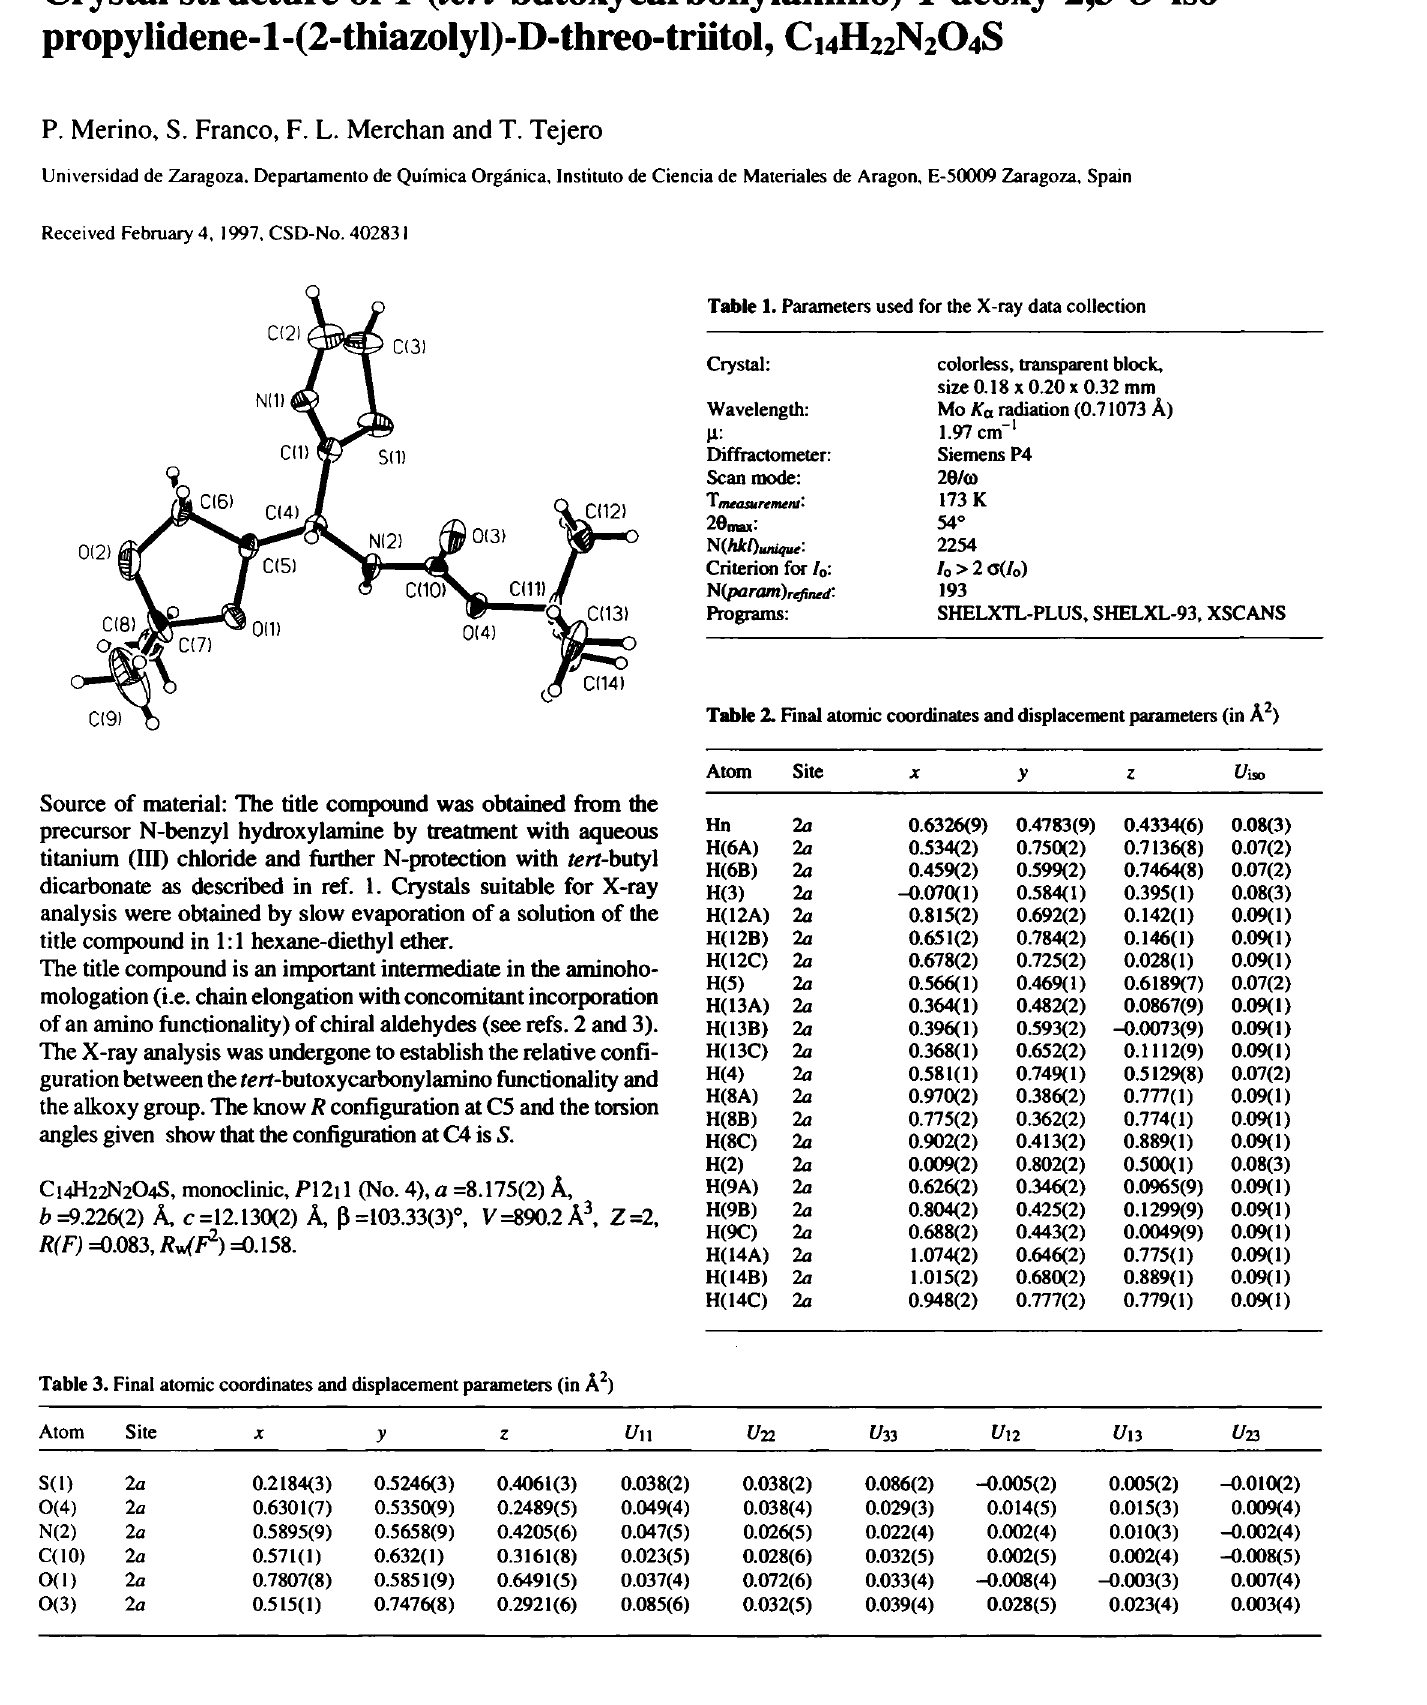
Table 3. Final atomic coordinates and displacement parameters (in